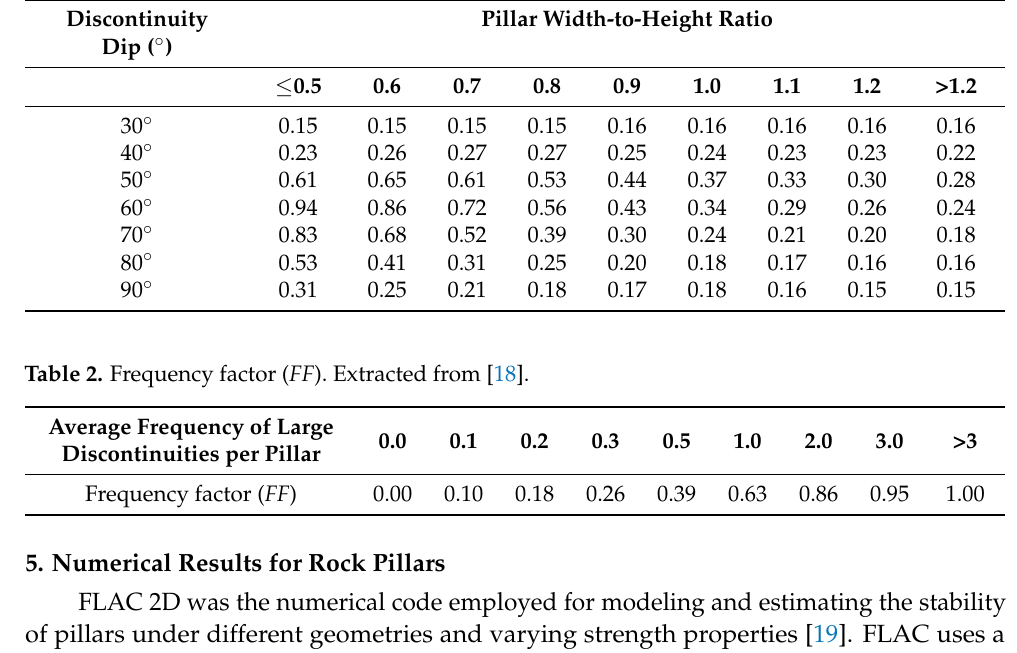
Table 1. Discontinuity dip factor ( DDF ). Table extracted from [18]. Discontinuity